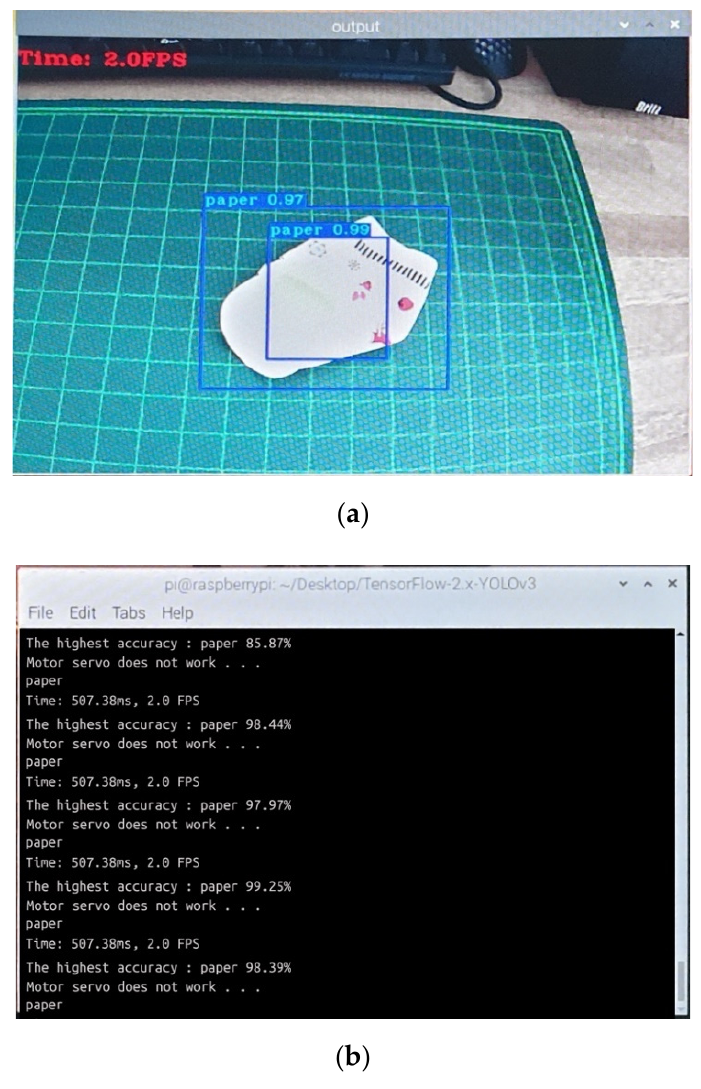
Figure 8. YOLO object detection results from camera point ‐ of ‐ view ( a ) and detailed information in terminal ( b ).